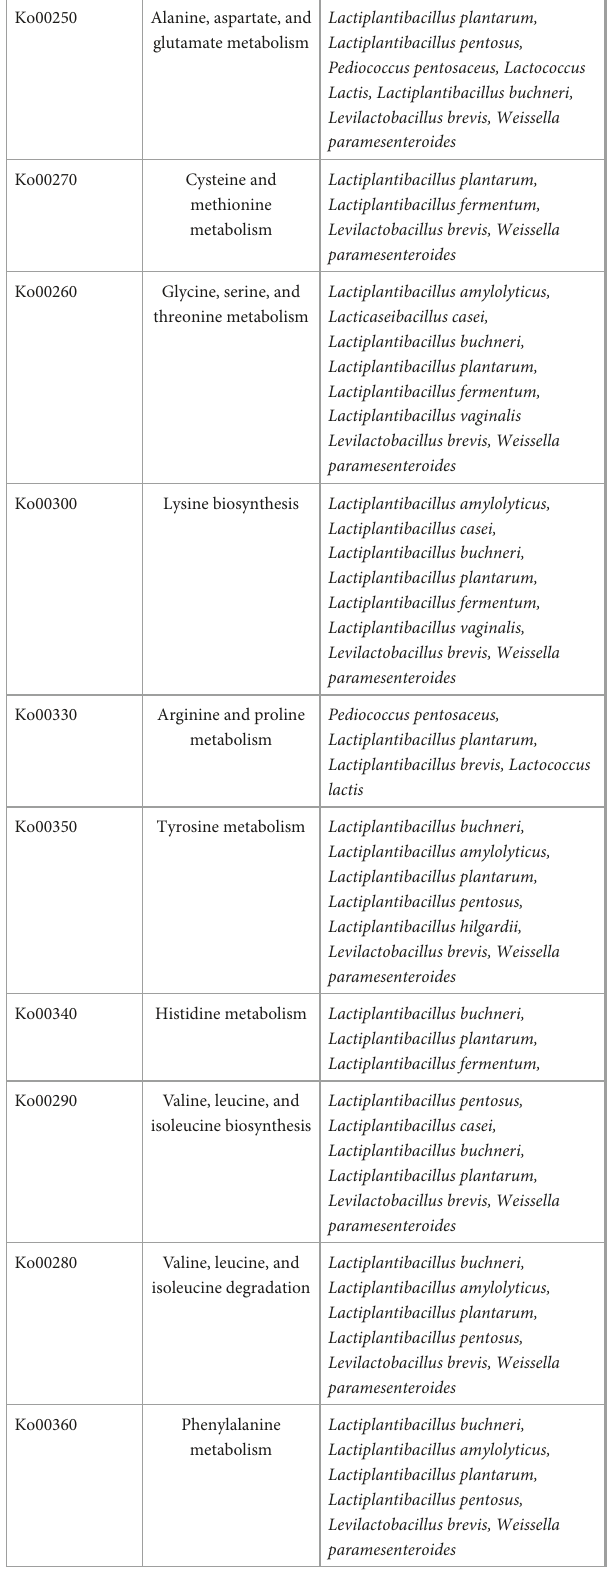
annotated to KEGG